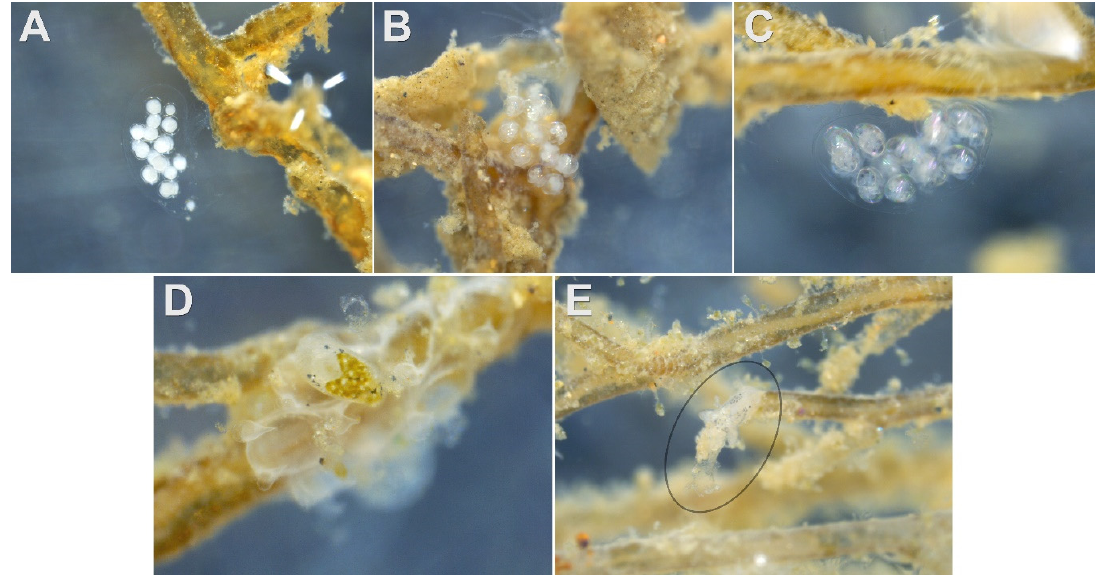
Figure 3. The several stages of development of Tellenia adspersa documented in laboratory. ( A ) Batch of eggs after 2 days at laboratory; ( B ) intermediate phase of development; ( C ) metamorphic individuals inside eggs; ( D ) juveniles after hatching; ( E ) a juvenile days after hatching.